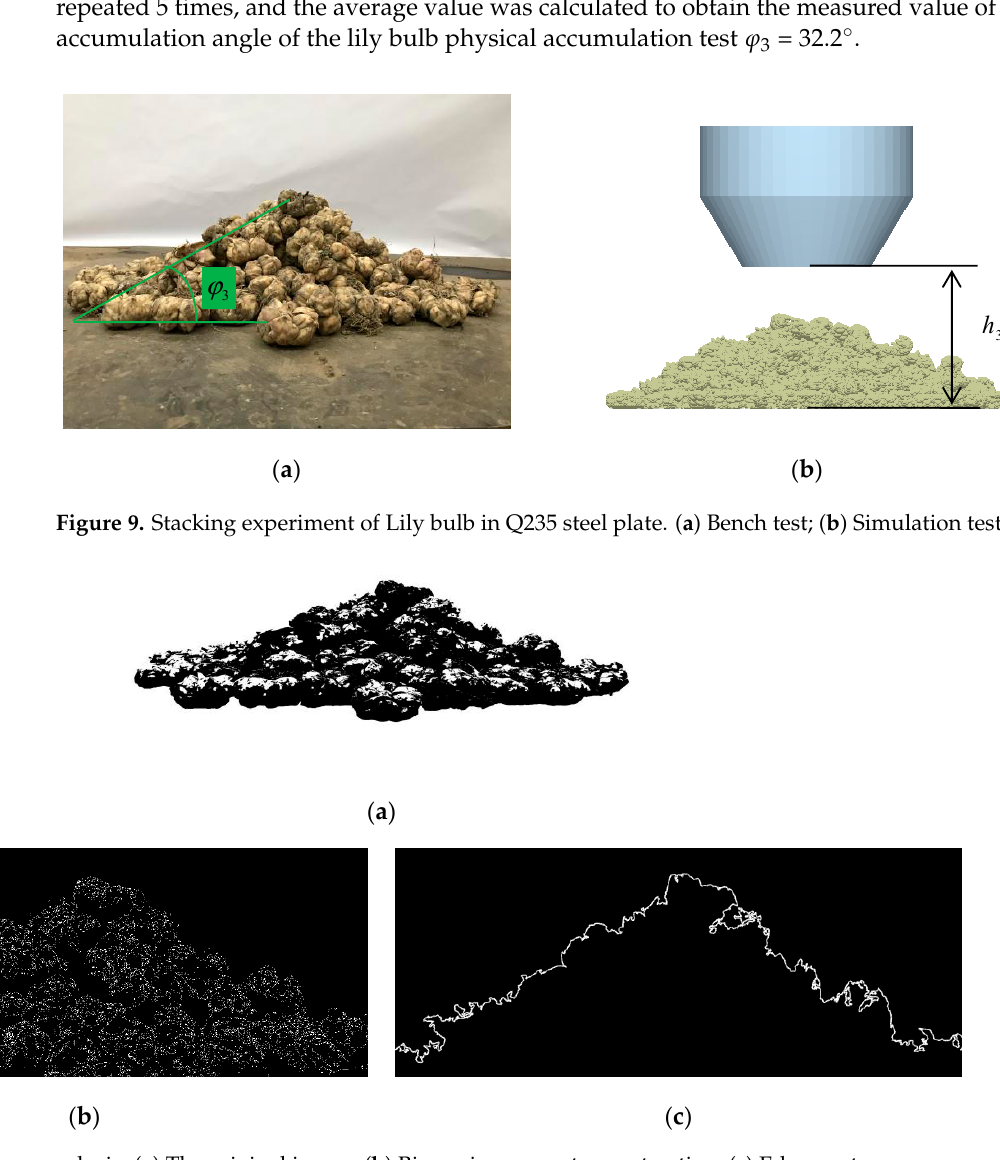
Figure 10. Image analysis. ( a ) The original image; ( b ) Binary image contour extraction; ( c ) Edge contour. In the EDEM simulation test, the calibrated contact parameters of the lily bulbs and Q235 steel were used; the collision recovery coefficient X 1 , the static friction coefficient X 2 , and dynamic friction coefficient X 3 of the lily bulbs were selected as test factors. The relative error of the stacking angle between the simulation and the bench tests was taken as the test index. The calculation formula (Formula (7)) for the relative error of the stacking angle Δ was